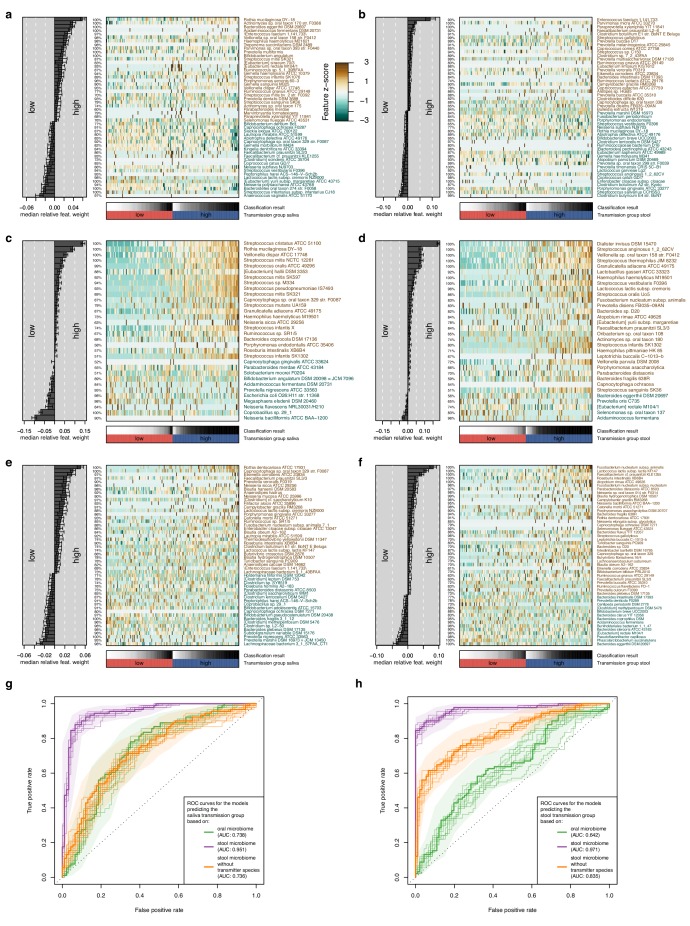
Multivariable statistical models reveal links between both oral and gut microbiome features with transmission levels.Models were trained from oral and gut microbiome features to classify subjects into ‘high’ and ‘low’ transmission individuals (see Materials and methods). Model interpretation plots show the median relative model weight (barplots on the left) of the top selected features, the robustness (the number of cross-validation folds in which the respective feature had a non-zero weight; percentages next to the barplot), and the feature z-scores across samples, ordered by group and classification score (heatmap and annotations below). Plots are shown for models trained on the salivary microbiome, predicting the saliva transmission group (a) and the stool transmission group (b); trained on the stool microbiome, predicting the saliva transmission group (c) and the stool transmission group (d); and trained on the stool microbiome after exclusion of frequently transmitting species, predicting the saliva transmission group (e) and the stool transmission group (f). (g) Receiver operating characteristics (ROC) curves for the three models shown in (a, c, e). (h) ROC curves for the three models shown in (b, d, f).